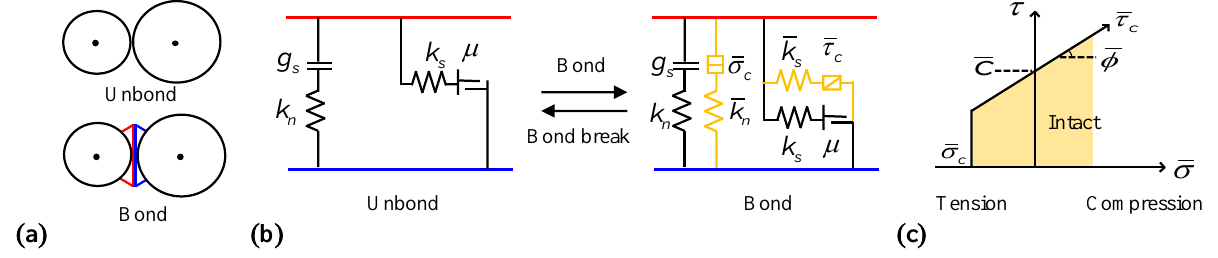
Figure 1. Parallel bond model. ( a ) Model diagram; ( b ) model theory; ( c ) strength criterion.